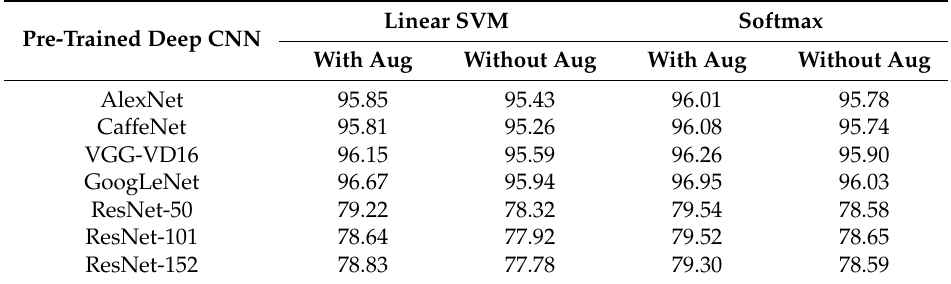
Table 2. Classification accuracy (%) with and without data augmentation in framework of Architecture (I) on UC Merced dataset.